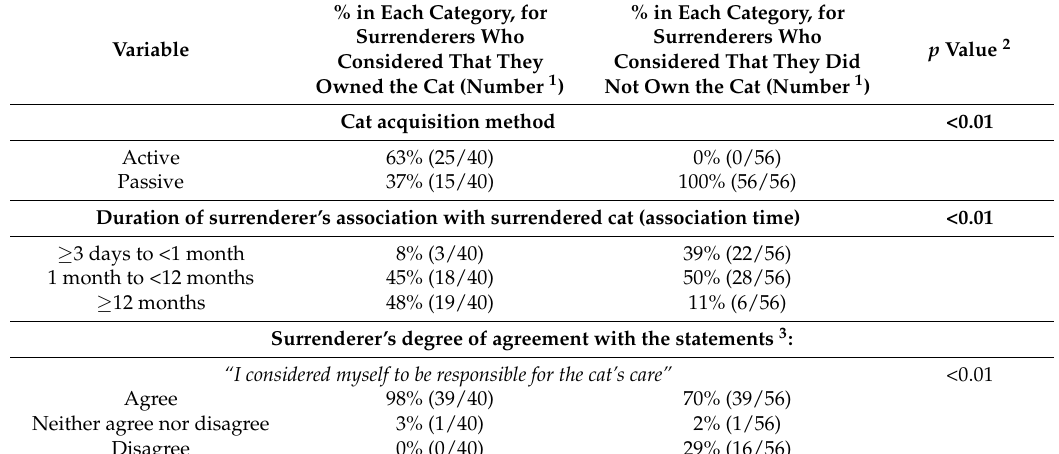
Table 2. Distributions of perceived ownership of cats at the time the cat was surrendered by each of cat acquisition method, association time and surrenderer’s relationship with, interactions with and caretaking behaviours shown towards, the surrendered cat ( n =